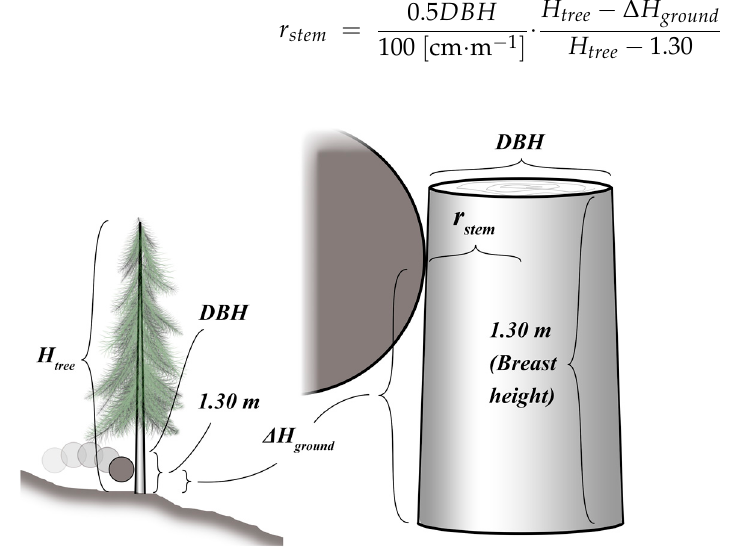
Figure 7. Parameters for the impacts against tree stems simplified as tall cones.